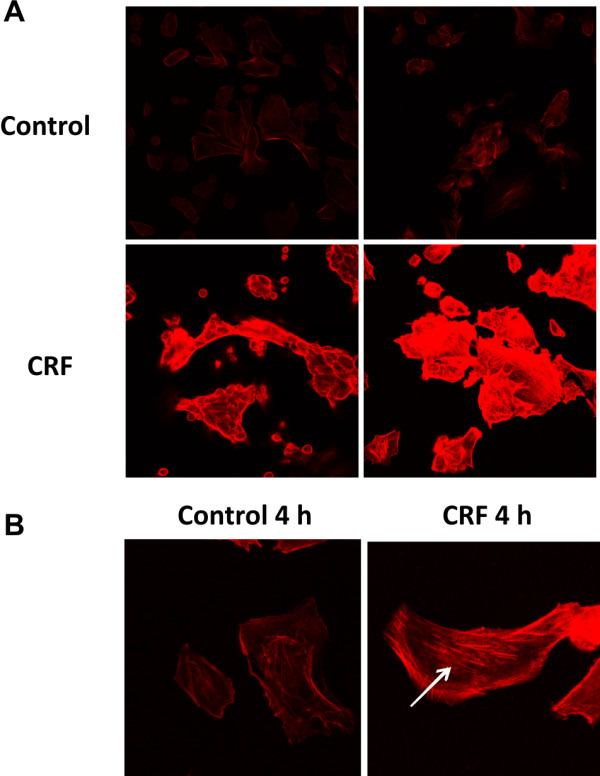
Effect of CRF on actin polymerization in 4T1 cells. 4T1 cells were cultured on coverglass and stimulated with CRF for 2 or 4 h. After fixation, cells were permeabilized and stained for F-actin with rhodamine-conjugated phalloidin, as described in Materials and methods. CRF treatment resulted in a more intense actin staining compared to untreated control, especially after 4 h (A). Moreover, CRF treated 4T1 cells showed more pronounced actin stress fibers compared to untreated control (indicated by the arrow). Pictures are representatives of two independent experiments.